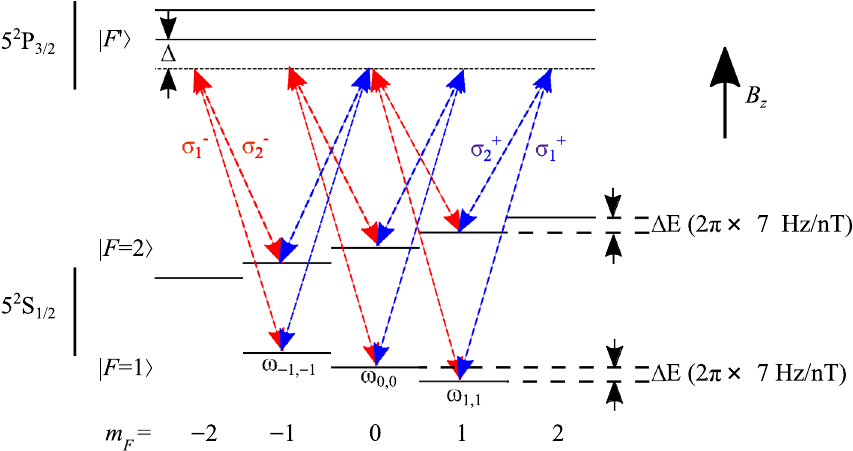
Figure 8. The 87 Rb ground state magnetic sub-levels and possible Raman transitions using the D 2 line of angular frequency ω . | F � and | F ′ � represent the ground and excited state energy levels, respectively, and m F = 0, ± 1, . . . , ± F are the projections of the total angular momentum F on the quantisation axis. The red and blue arrows show the possible transitions for Raman beams with σ + / σ − polarised light with a uniform axial magnetic field, B z , applied parallel to the Raman beam. Only three Raman transitions are allowed, with frequencies ω − 1, − 1 , ω 0,0 , and ω 1,1